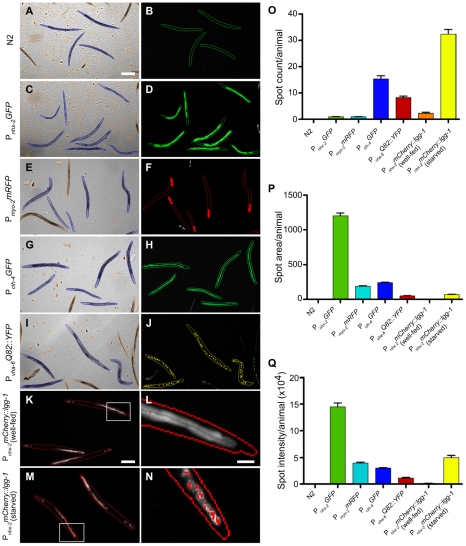
Automated detection and quantification of cells, tissues, subcellular protein aggregates or autophagy in individual animals.(A–J) The SpotDetector BioApplication was used to identify and quantitate different types of transgene expression (left of panels) in adult animals. The brightfield channel (left panels) was used to discriminate between complete adult animals (outlined in blue) and debris or incomplete animals (outlined in orange), while a fluorescence channel (colored overlays in right panels) was used to detect different types of fluorescently tagged transgenes in correctly identified objects. (K–N) Fluorescence images of well-fed (K) and starved (M) animals expressing the autophagy marker, mCherry::LGG-1. In well-fed animals, mCherry::LGG-1 was diffusely cytoplasmic (K). In contrast, induction of autophagy by starvation leads to a punctate fluorescence pattern within intestinal cells, as LGG-1 is incorporated in to autophagosomes (M). (L, N) Higher magnification of the boxed areas in (K) and (M), respectively. (O–Q) The different types of transgene expression were quantified by spot count (O), spot area (P) or spot intensity (Q) per animal. Spot count, spot area and spot intensity values for each of the transgenic lines were significantly (Student's t-test, P<0.001) different to that of N2 animals. Data derived from 10–50 wells containing ∼20 animals/well. Scale bars, 225 µm (A–J, K, M), 50 µm (L, N).